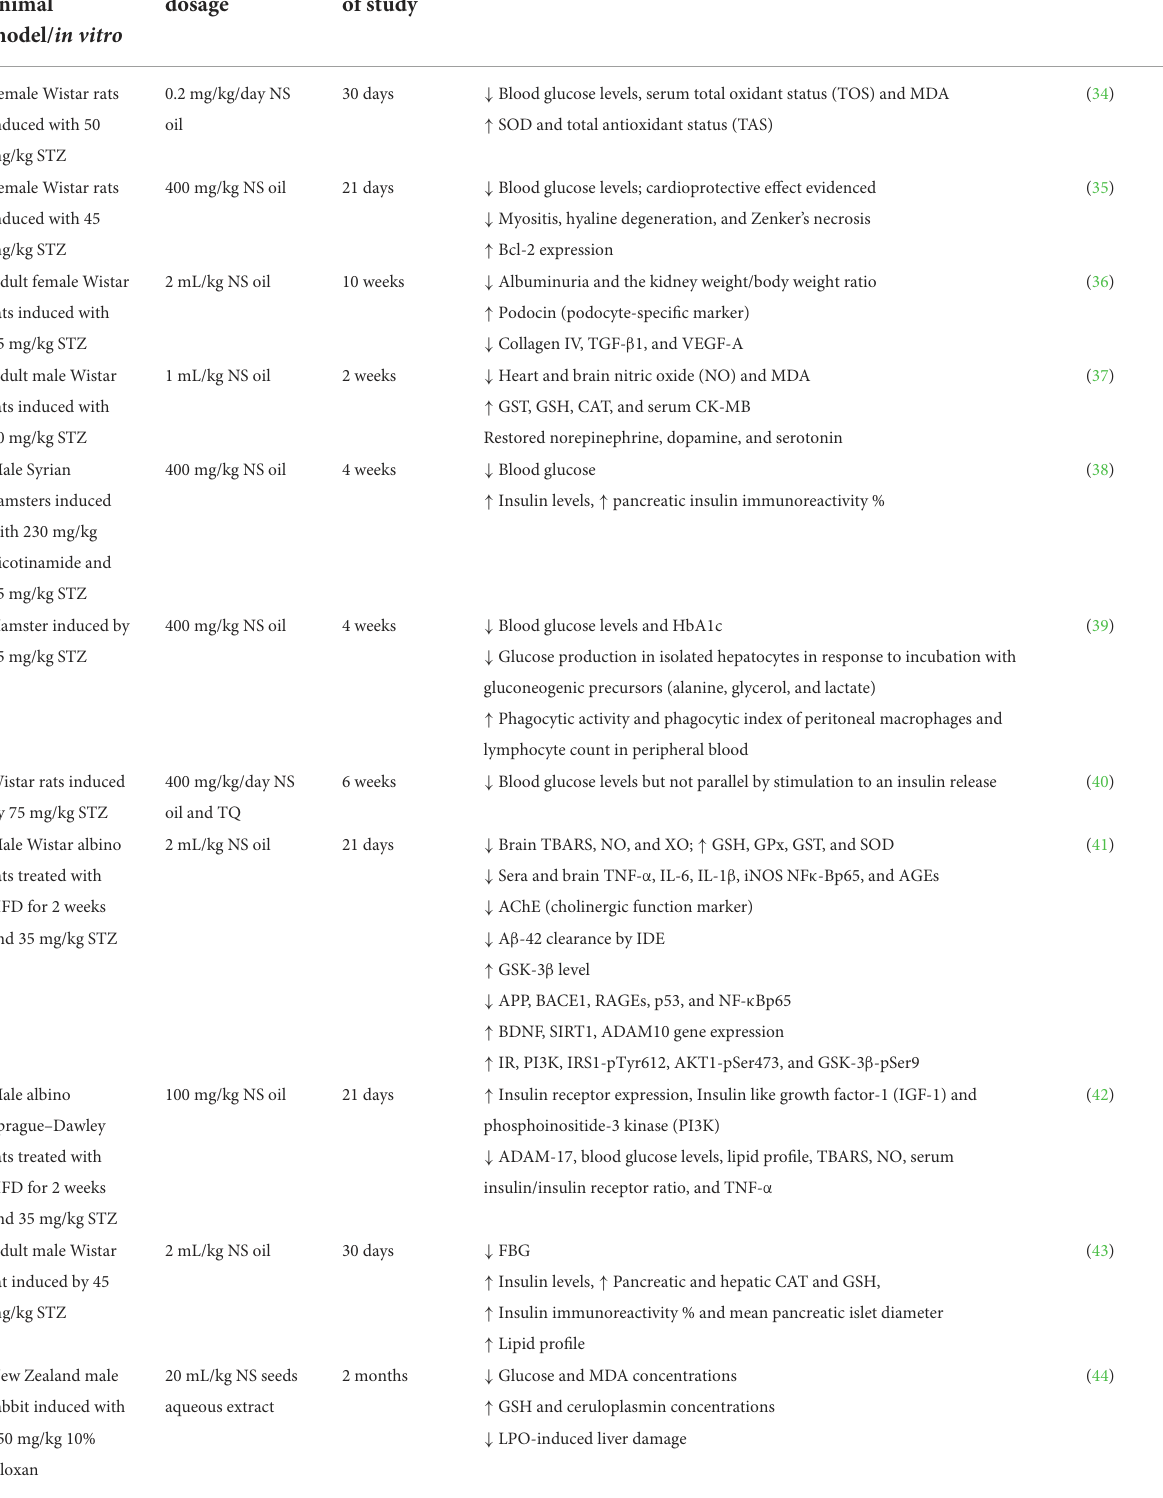
TABLE 2 Summary of NS’s effects on DM and its complications from in vivo and in vitro studies. Diabetic Treatment Duration Outcomes of the study/major animal dosage of study model/ in vitro